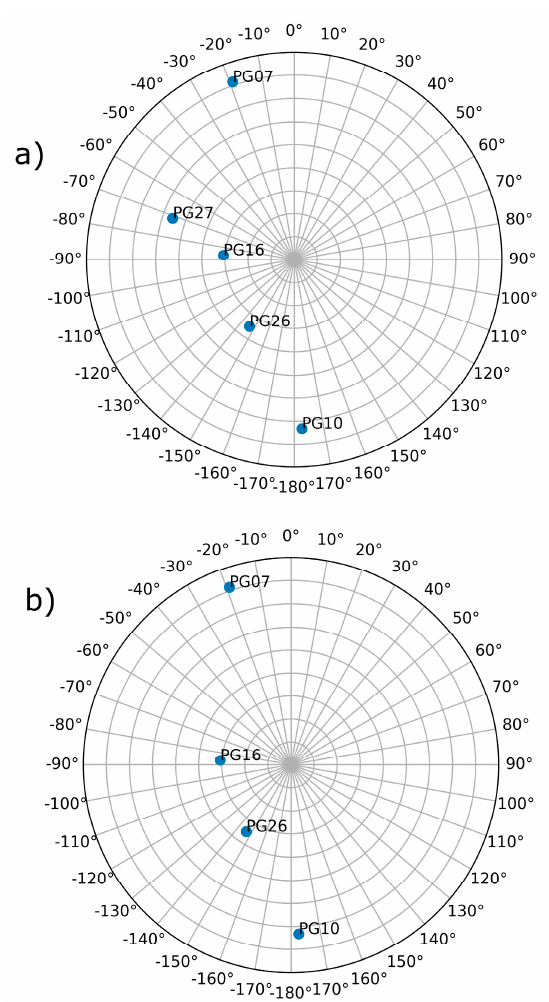
Figure 3. Satellite visibility during the experiment. Bottom panel ( b ) shows the skyplot with all visible satellites and the top panel ( a ) shows the skyplot with Satellite 27 removed.